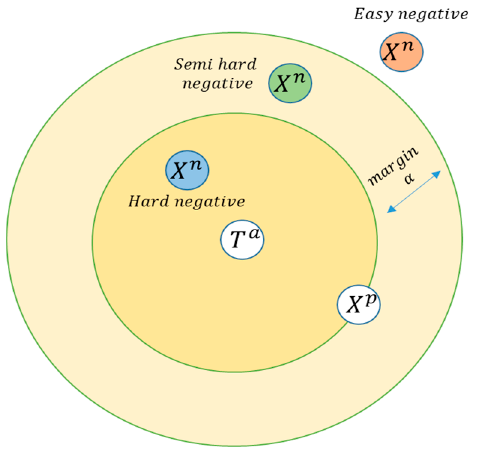
Figure 5. Semi-hard triplet selection scheme.